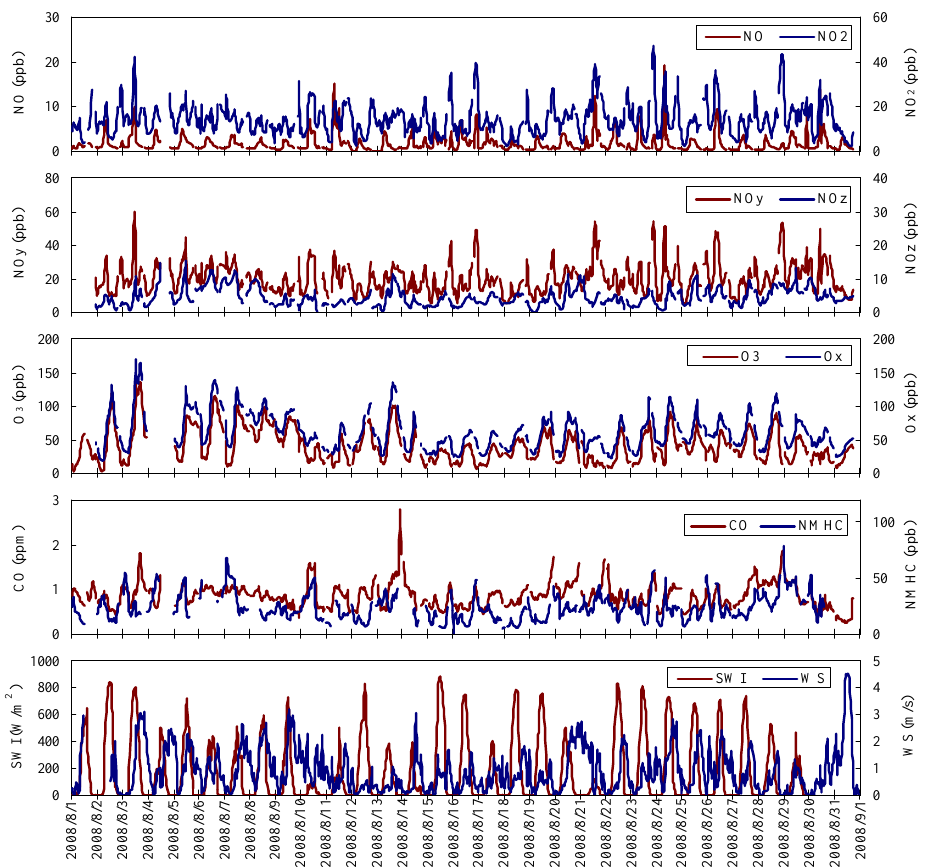
Fig. 1. Time series of the hourly averaged concentrations of the trace gases, wind speed, and short wave irradiance measured at the PKU station during August